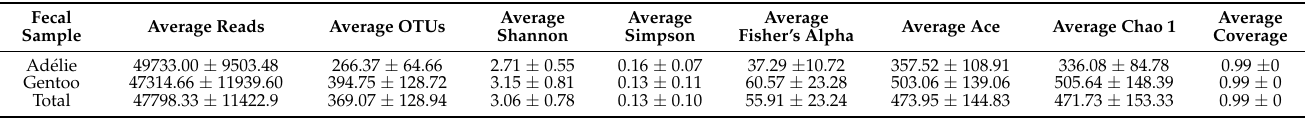
Table 1. Comparison of phylotype coverage, richness, and diversity indices of the 16S rRNA gene library obtained from sequencing analysis of penguin